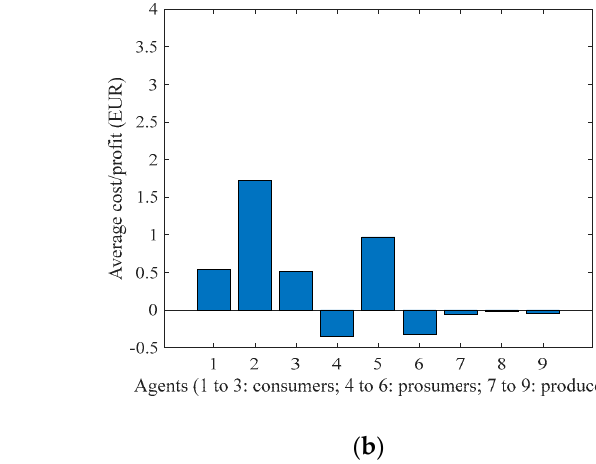
Figure 6. Overall profits achieved by individual agents. ( a ). Baseline solution without LEM. ( b ). Best solution found by CE-CMAES algorithm with LEM.